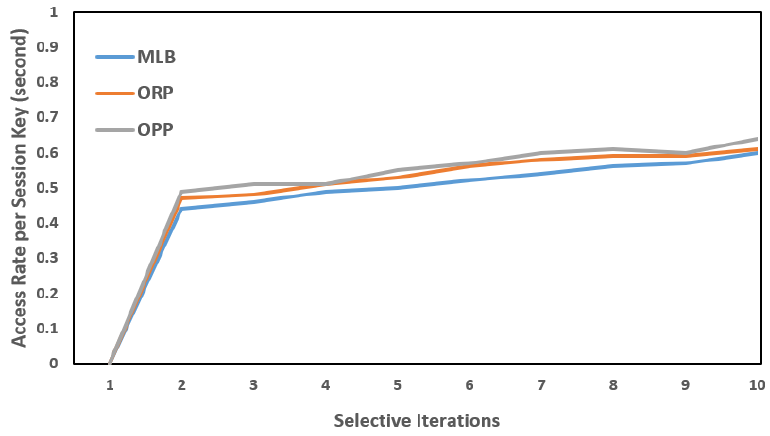
Figure 8. AV access rates per session key: session key = 2 s; time period = 30 min .